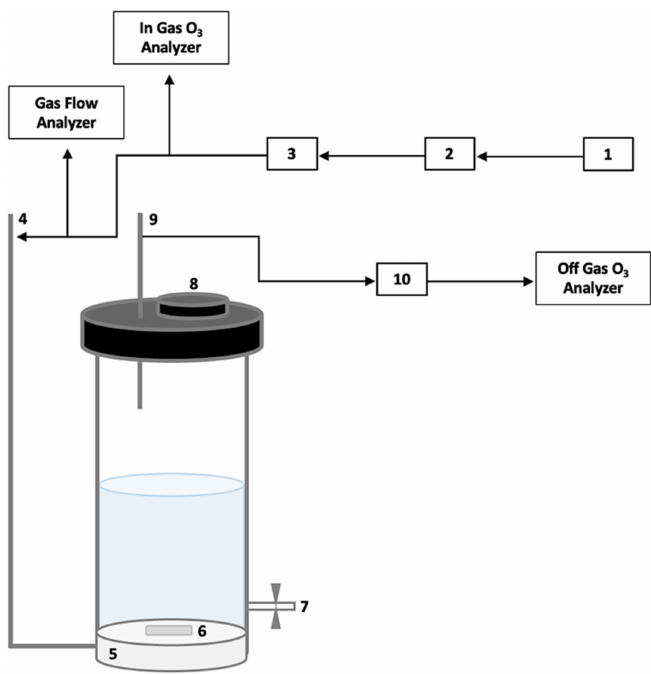
Figure 2. A semi-batch ozonation reactor: (1) oxygen gas and flow rate gauge, (2) air drier and humidity indicator, (3) O 3 gas generator, (4) O 3 gas input, (5) O 3 gas diffuser, (6) magnetic stirrer, (7) sampling port, (8) solution input, (9) O 3 gas output, (10) dryer for O 3 -saturated